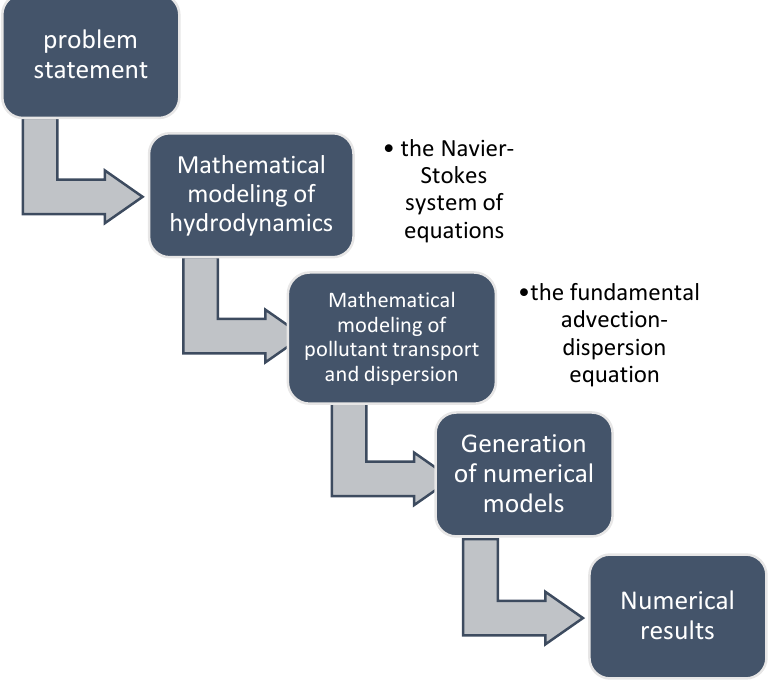
Figure 2. Research